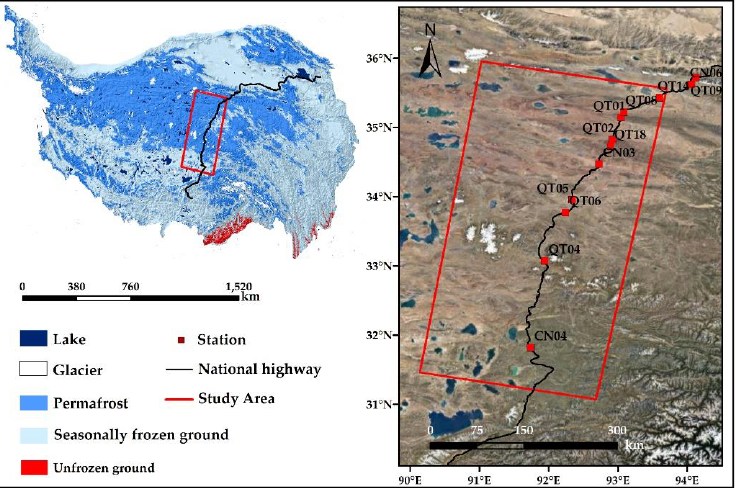
Figure 1. The overview of the study area. The base map is the map of the permafrost [10], glaciers [62], lakes [63], and topographic map from SRTM data [64].